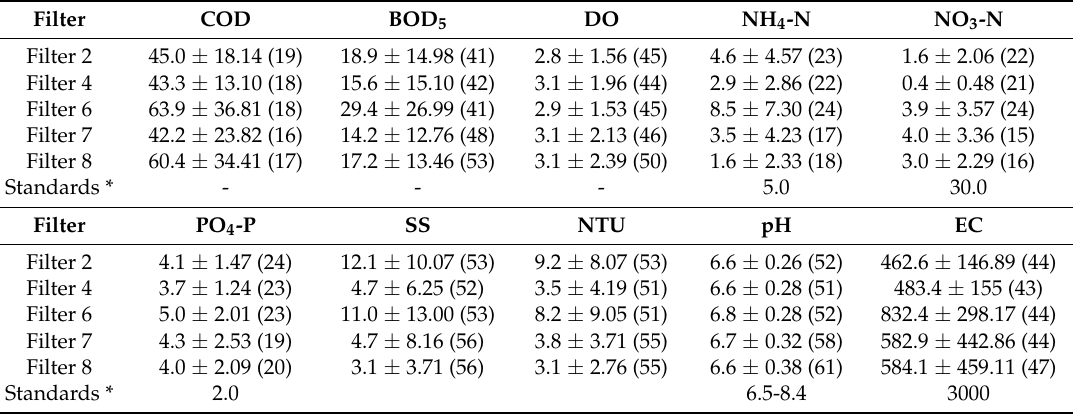
Table 1. Filter outflow (irrigation water for plants) water quality (mean ± standard deviation (number of samples)) compared to common standard